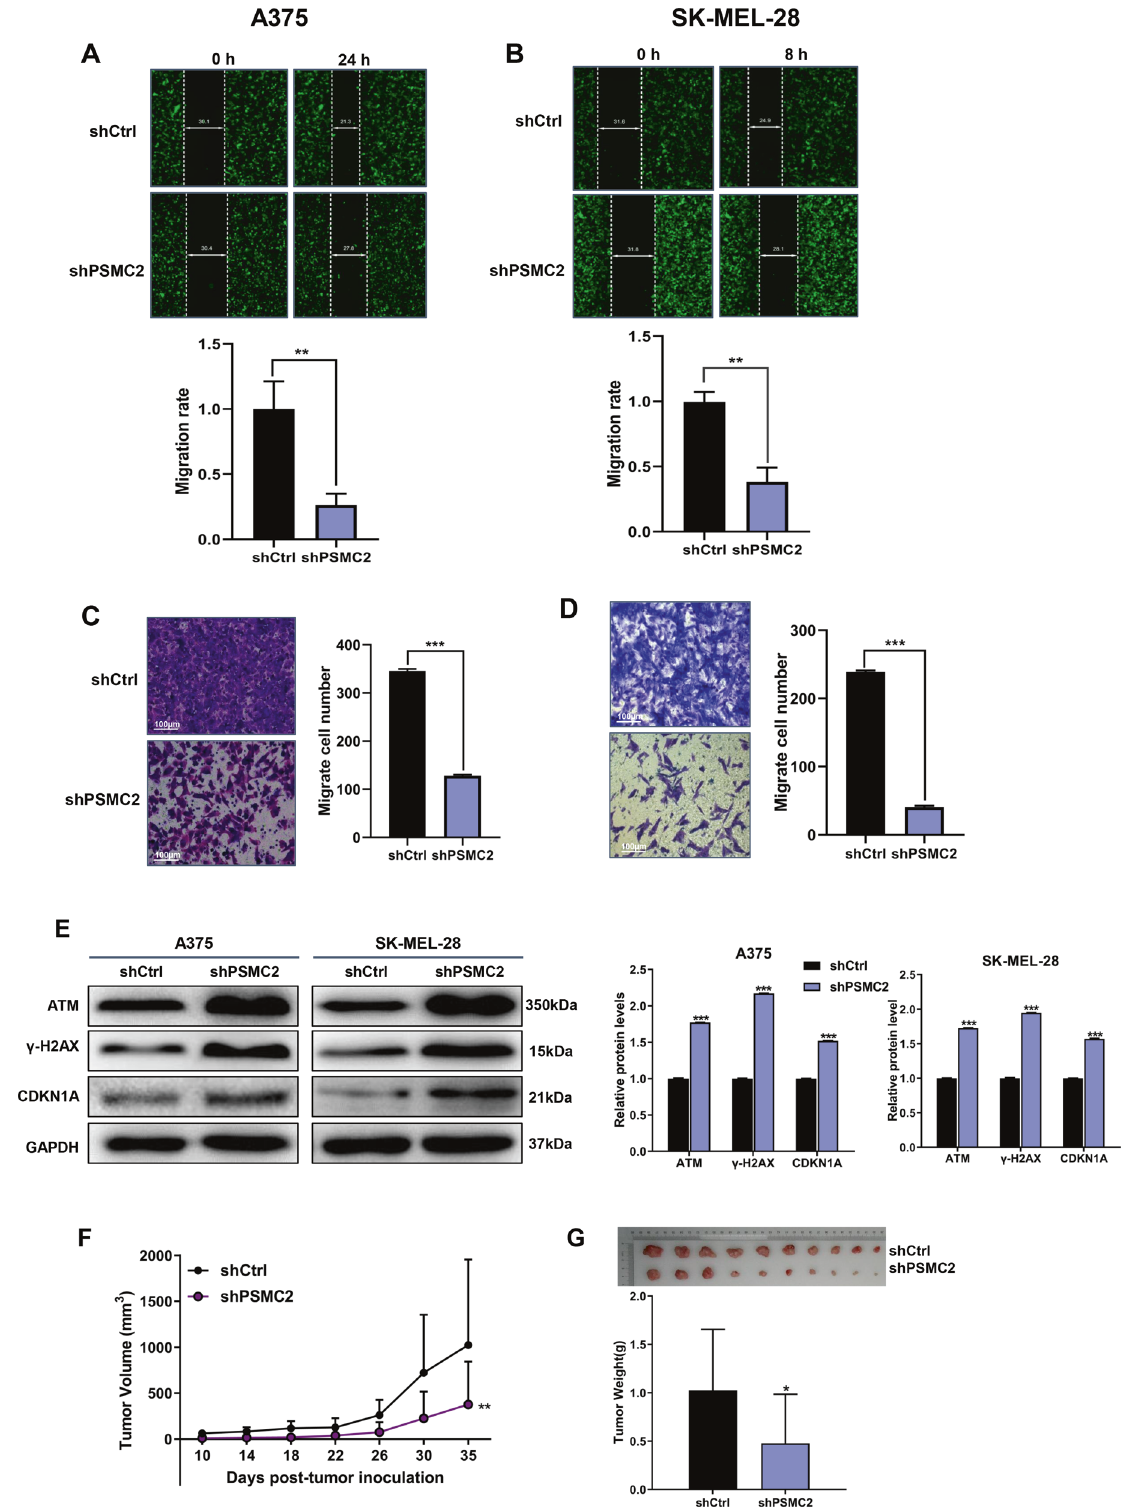
Patients and tissue samples One hundred fi ve cases of SKCM tissues and adjacent normal tissues (ANT) were obtained from patients hospitalized in the Zhongshan Hospital, Fudan University, and no patients received radiotherapy